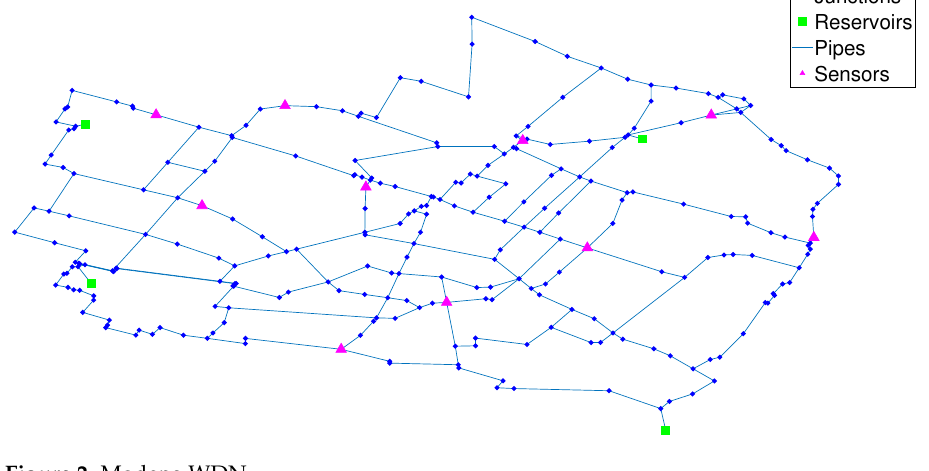
Figure 2. Modena